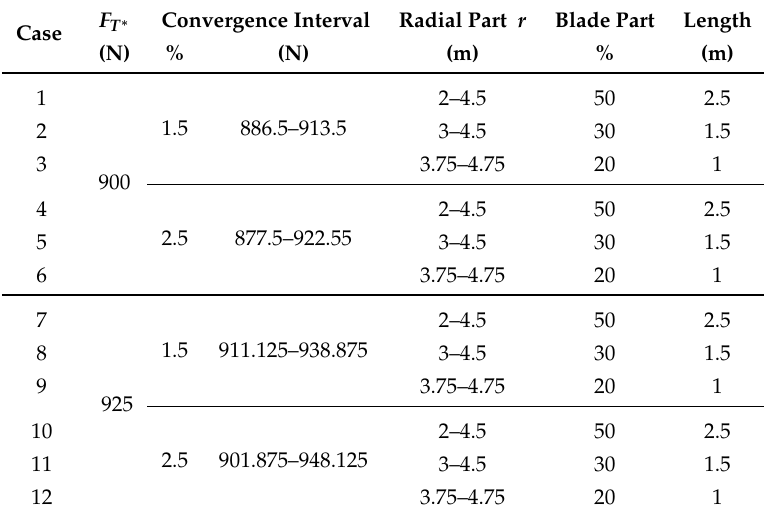
Table 1. Optimization set-ups for different parts of the blade, aimed values and convergence interval around the aimed